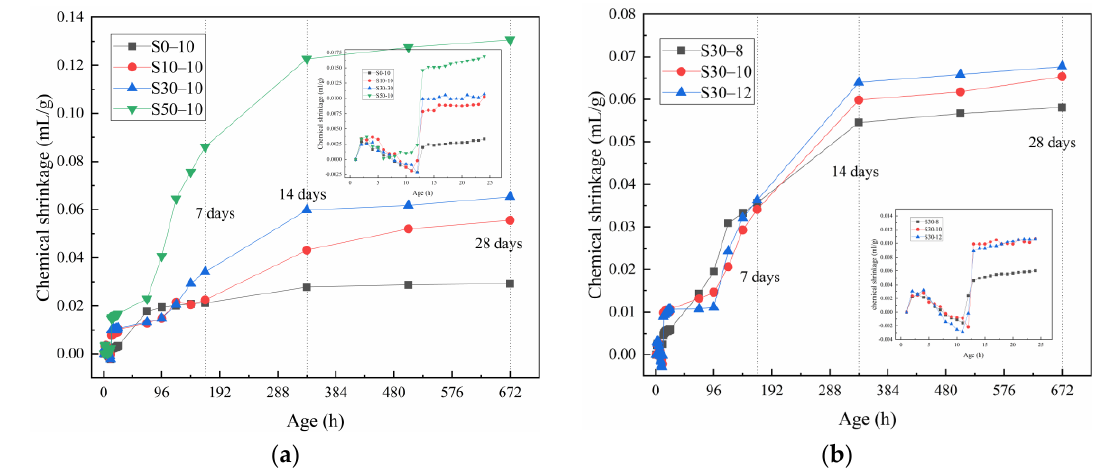
Figure 6. Chemical shrinkage of the alkali-activated metakaolin-based geopolymer specimens according to the ( a ) slag and ( b ) Na 2 O content. The insets show the chemical shrinkage in the first 24 h.